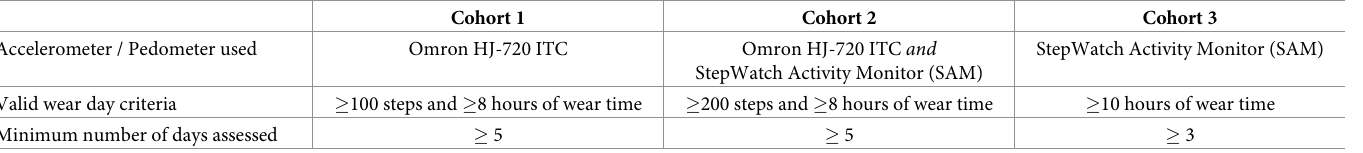
Table 1. Physical activity assessment details by cohort.